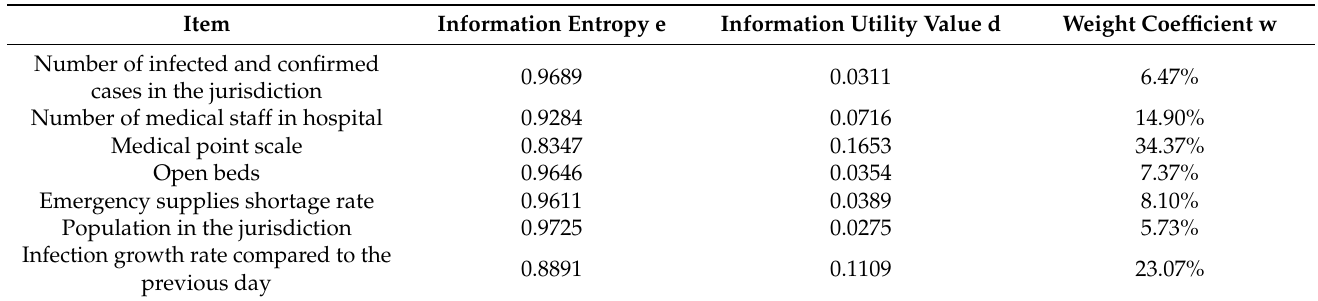
Table 2. Summary of calculation weight results by entropy.